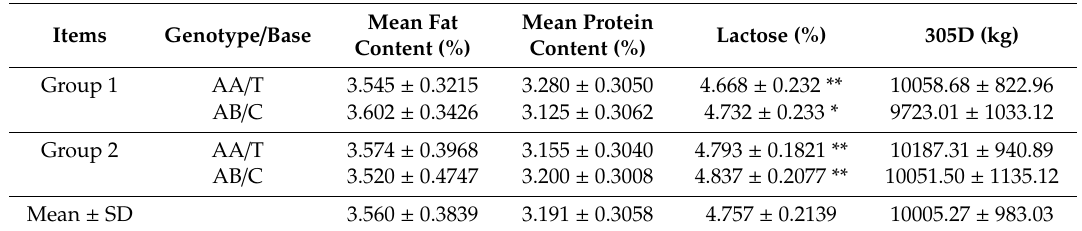
Table 4. Statistical analysis the milk components (mean fat and protein contents, Lactose) and 305D yield of di ff erent genotypes in Chinese Holstein dairy